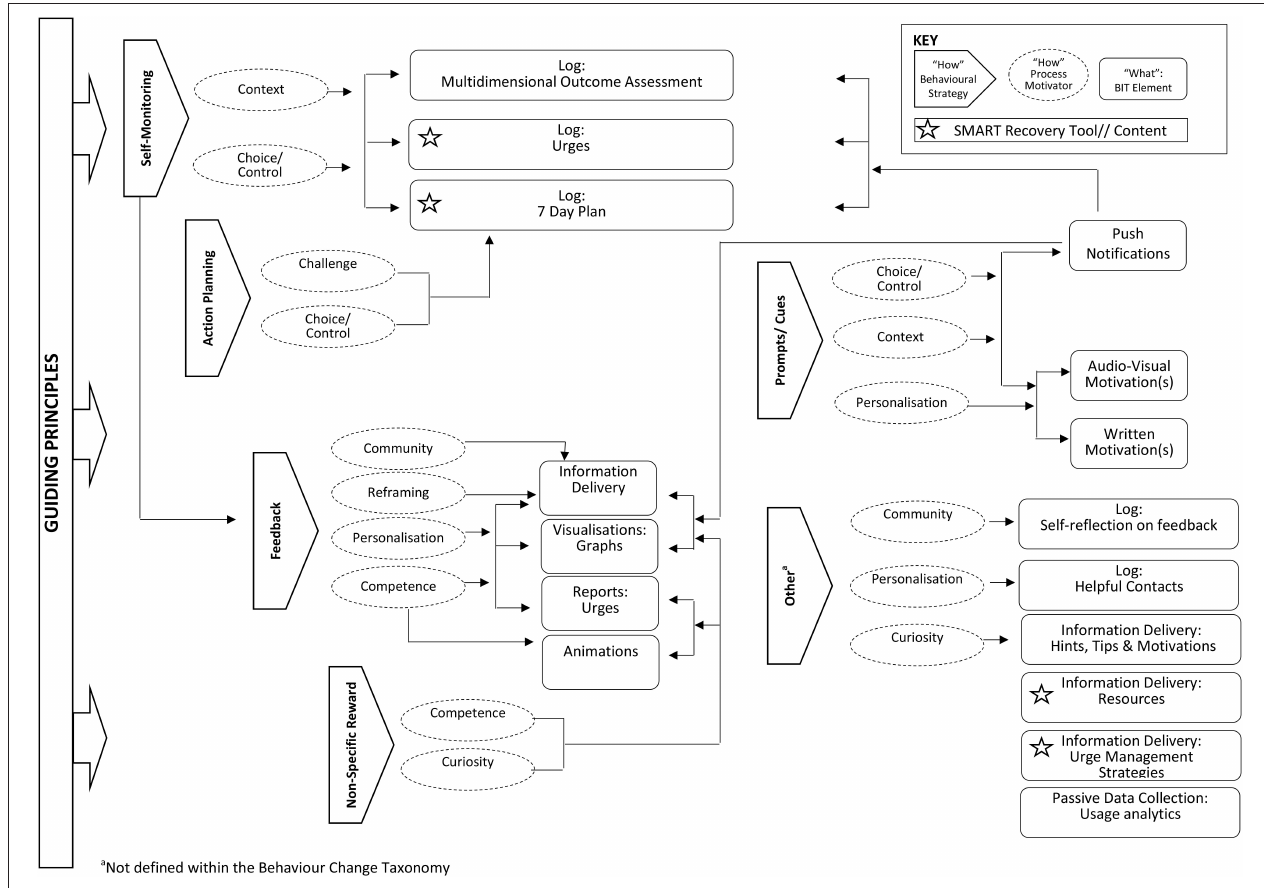
FIGURE 3 | Relationship between app features and associated behavioural